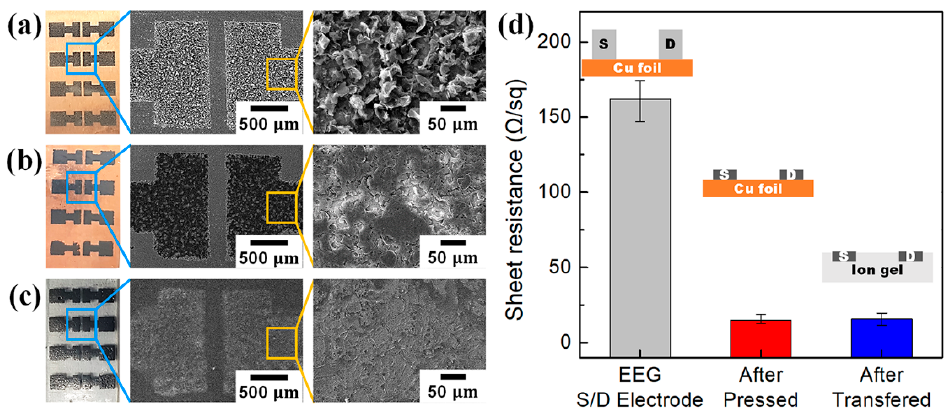
Figure 6. Photo and SEM images of EEG S/D electrodes after ( a ) spray coating onto Cu foil, ( b ) hot pressing, ( c ) transferring to ion gel dielectric layer, and Cu foil etching. ( d ) Changes in the sheet resistance of EEG S/D electrodes after each step.